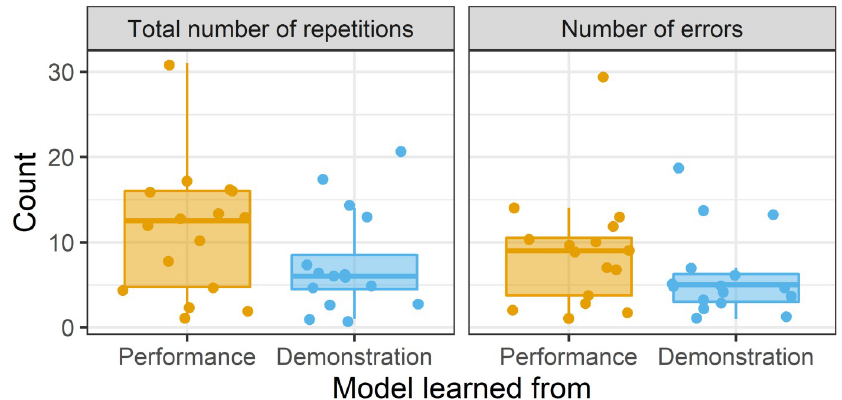
Fig 4. Boxplots showing learning rates when learning from Performance (orange) and Demonstration (blue). Learning rates calculated as total number of repetitions (left) and total number of errors (right). Points show individual